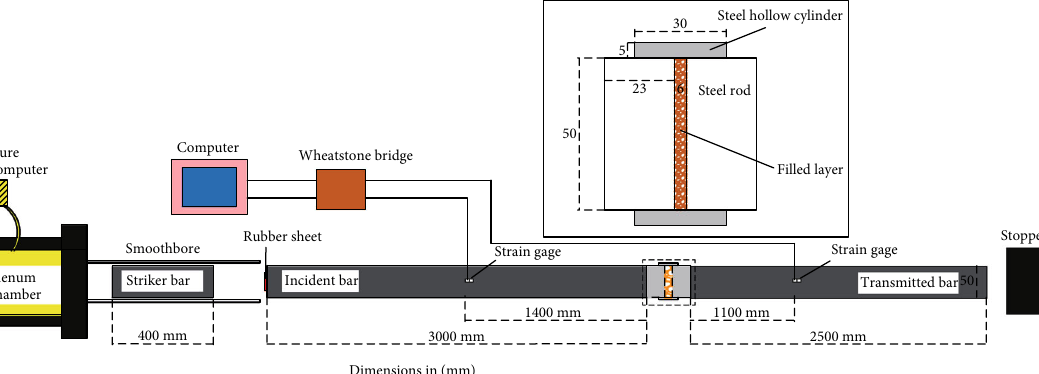
Figure 1: Split Hopkinson pressure bar.